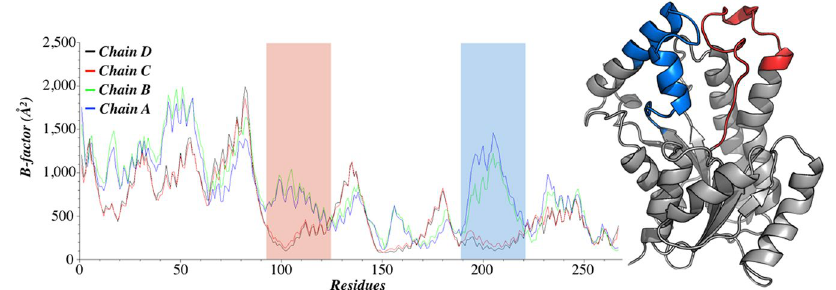
Figure 4. B-factor for each of the subunits of tetrameric InhA during the simulation at sucrose concentration of 25 mg mL − 1 . The two regions showing the largest variations among the subunits A/B and C/D were highlighted. These same regions are colored in the three dimensional structure on the right side. Image prepared with QtiPlot 29 and PyMOL 30